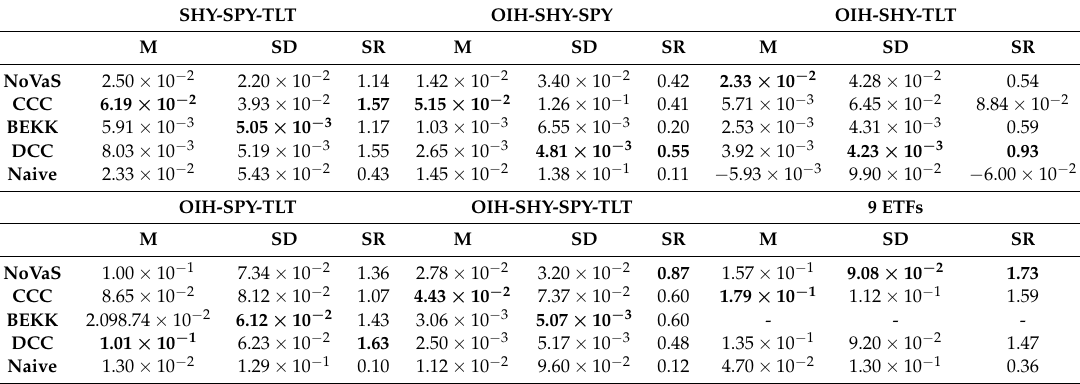
Table 12. Mean (M), standard deviation (SD) and Sharpe ratio (SR) of portfolio returns with weekly rebalancing and with weights computed on 2/3 of available